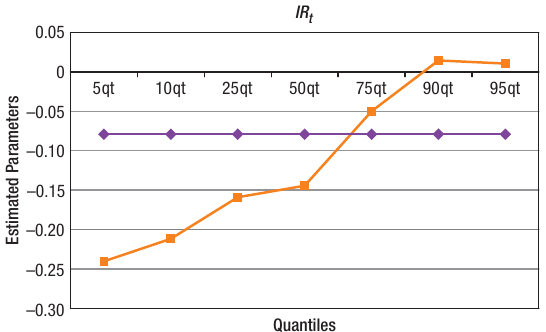
Fig. 6. Estimated parameters of relationship between I Notes: 1. The linear relationship represents OLS regression.